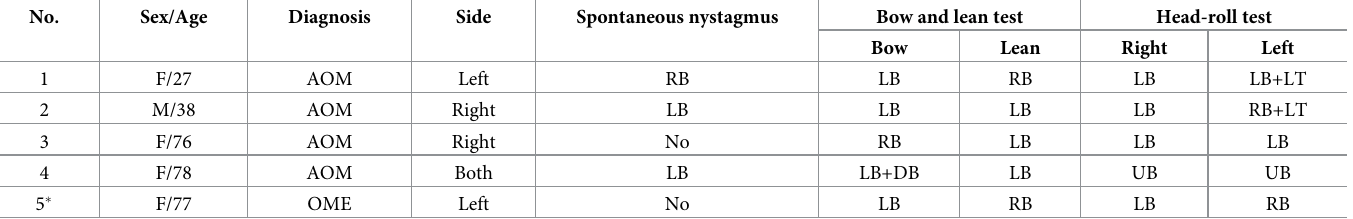
RB, right-beating; LB, left-beating; LT, left-torsional; DB, down-beating; UB, up-beating. � This patient was diagnosed with diffuse large B cell lymphoma in the left external auditory canal and underwent radiotherapy 1 year prior to the onset of OME in the left